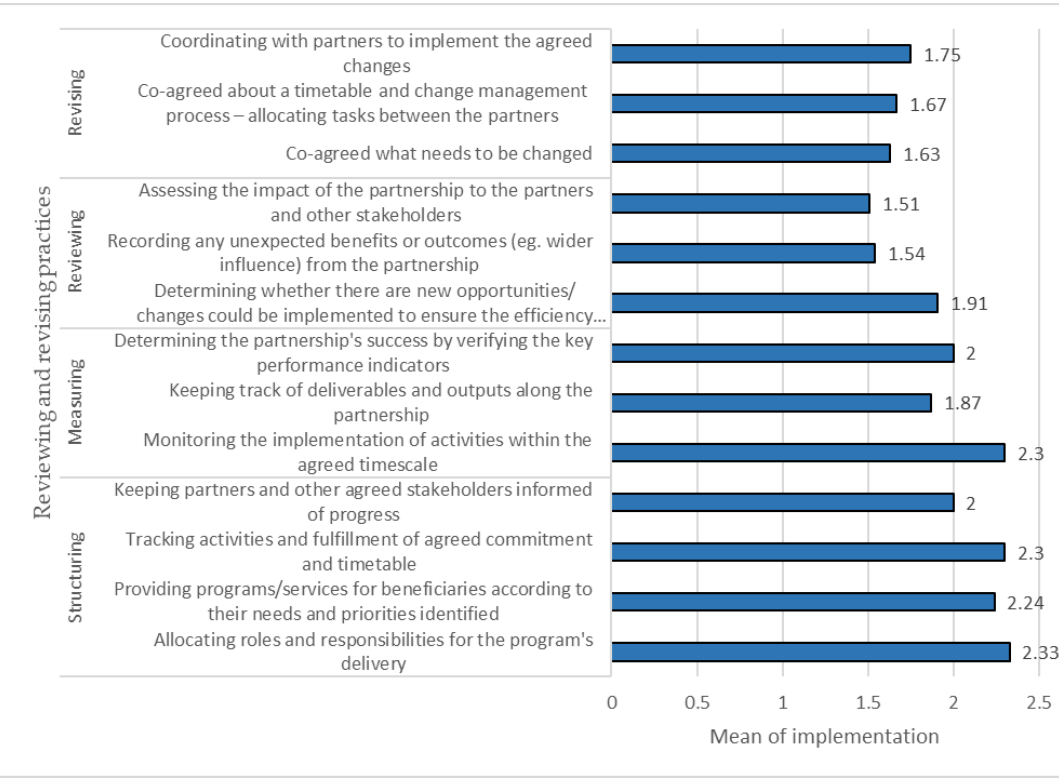
Table 11. Distribution of partnerships according to use of evaluation methodology. Variable ( n = 33)